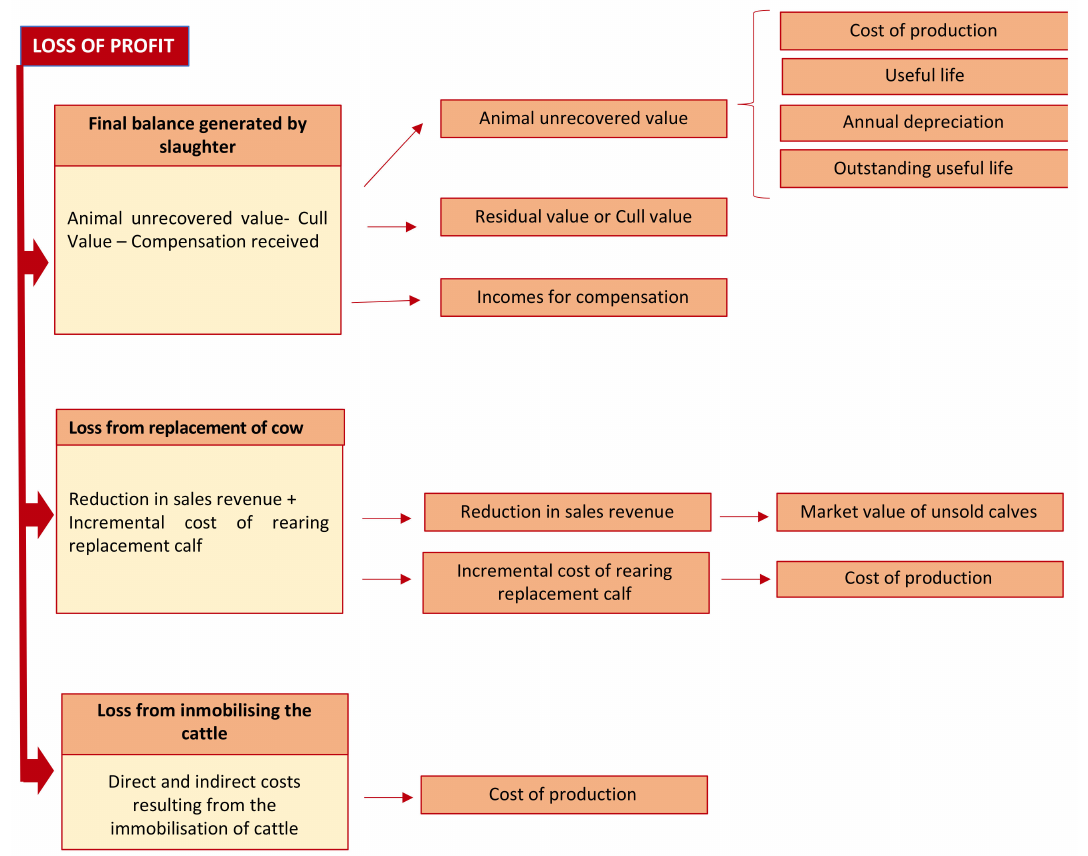
Figure 2. Model for estimation of the loss of